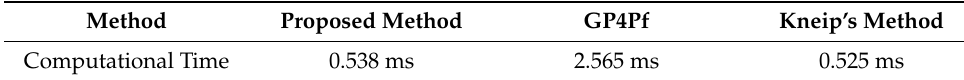
Table 1. Computational time.